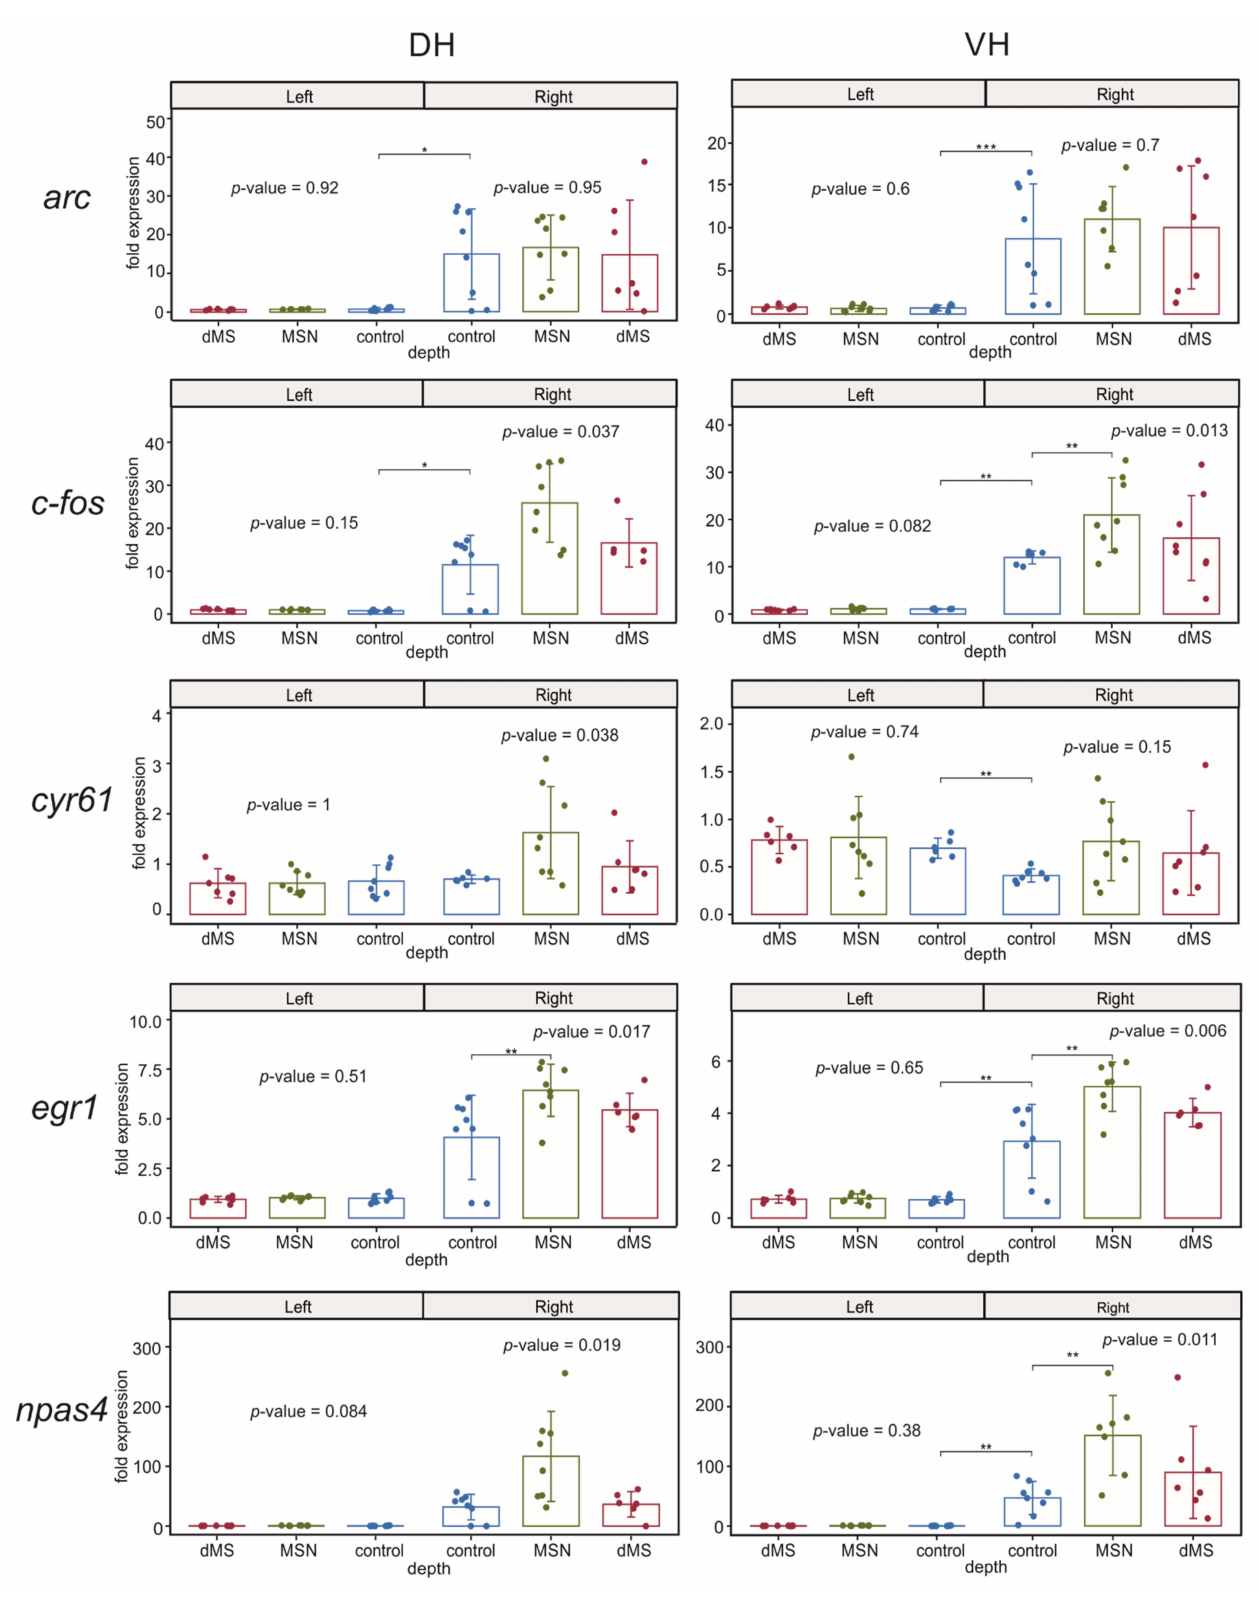
Figure 3. Changes in the expression of early genes after stimulation of the dorsal medium septum (dMS) and medial septal nucleus (MSN) in dorsal and ventral parts (DH and VH, respectively) of the left (intact) and right (damaged by implanted electrode) hippocampi. p -values are shown for Kruskal–Wallis test for comparison of three groups in one hemisphere. Interhemispheric